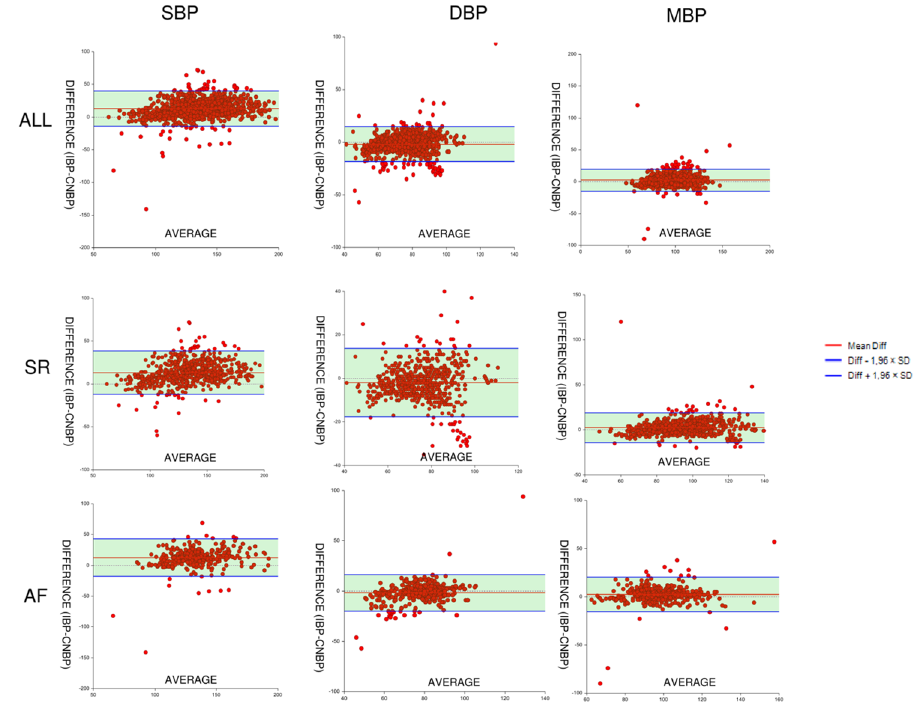
Figure 3. Bland-Altman agreement plots for systolic, diastolic, and mean blood pressure during sinus rhythm and atrial fibrillation. Values in mmHg. SR: sinus rhythm, AF: atrial fibrillation, SBP: systolic blood pressure, DBP: diastolic blood pressure, MBP: mean blood pressure, CBNP: continuous noninvasive blood pressure, IBP: invasive blood pressure, SD: standard deviation.